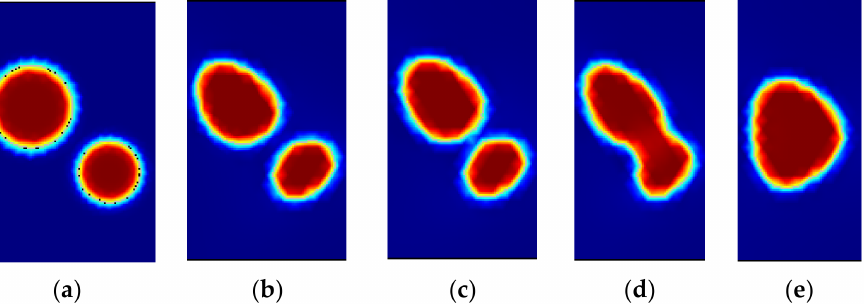
Figure 7. Oil droplet coalescence process under the coupling of electric field and flow field. ( a ) 0 s, ( b ) 0.1 s, ( c ) 0.2 s, ( d ) 0.3 s, ( e ) 0.4